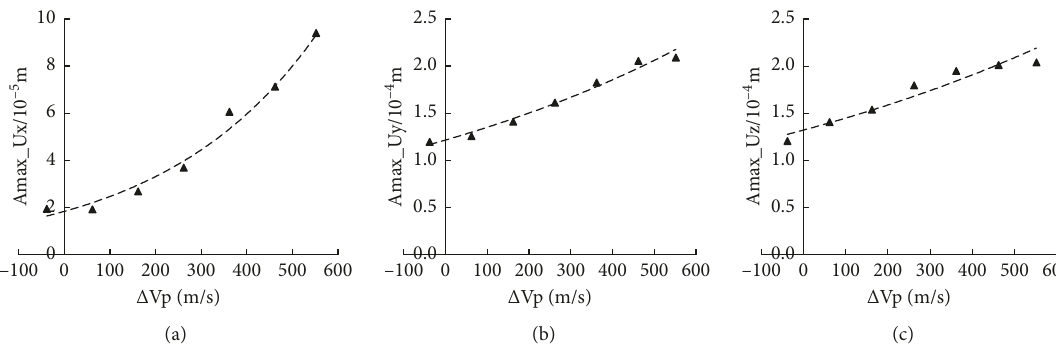
Figure 7: Spectral value of No. 8 measuring point of earth-rock dam with different hazard characteristics. (a) Spectral value corresponding to the dominant frequency of the vibration signal in the X direction. (b) Spectral value corresponding to the dominant frequency of the vibration signal in the Y direction. (c) Spectral value corresponding to the dominant frequency of the vibration signal in the Z